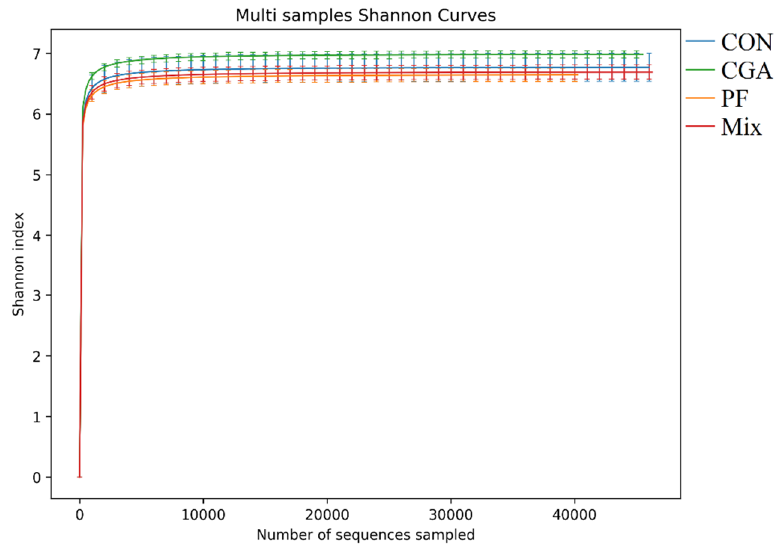
Figure 2. Rarefaction curve of the Shannon index. The horizontal coordinate is the number of sequencing strips randomly selected from a sample, and the vertical coordinate is the Shannon index. As the number of sequencing increased, more species were discovered until the species were saturated, and increasing the number of sampling strips did not reveal new